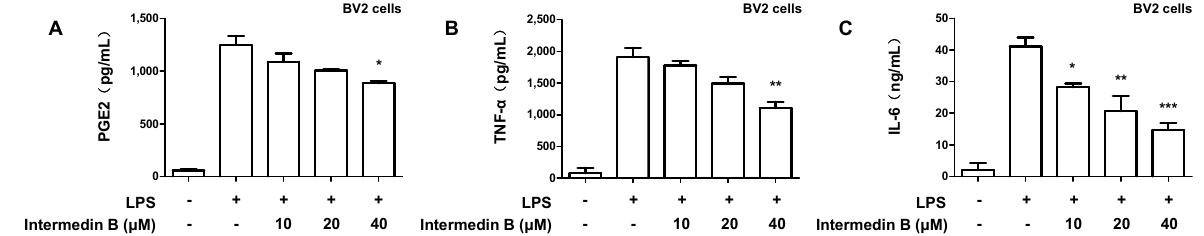
Figure 6. Effect of intermedin B ( 4 ) isolated from C. longa on inhibiting PGE2 ( A ), TNF- α ( B ), and IL-6 ( C ) production in LPS-induced BV2 microglia. Microglia were treated with each concentration of intermedin B ( 4 ) and cultured for 8 h, followed by treatment with LPS. After LPS treatment, the cells were cultured for 18 h, and the supernatant was collected to investigate the effect of PGE2, TNF- α , and IL-6 inhibition. Data are presented as the mean ± SD values of 3 independent experi- ments. * p < 0.05, ** p < 0.01, and *** p < 0.001 compared with LPS.